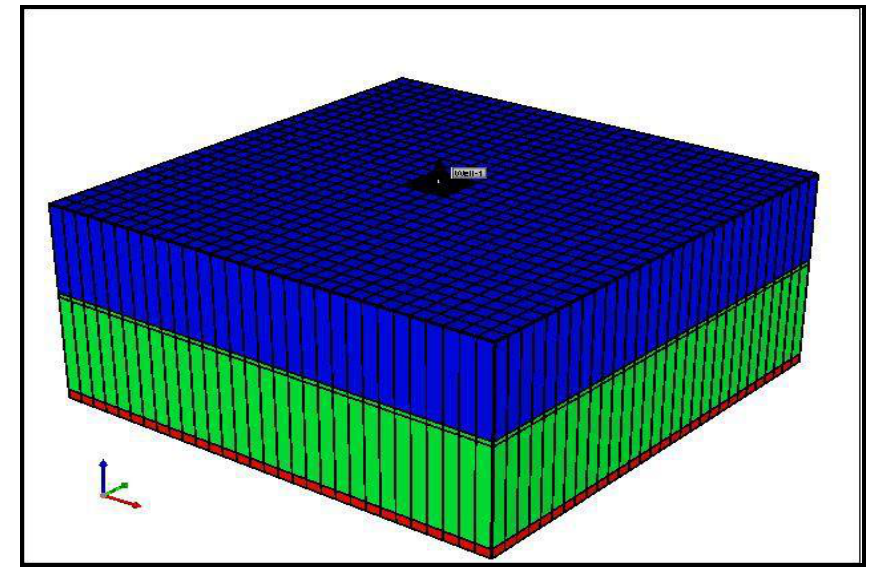
Figure 8. Three-dimensional view of rectangular reservoir model used in simulation. Table 1. Initial reservoir conditions.